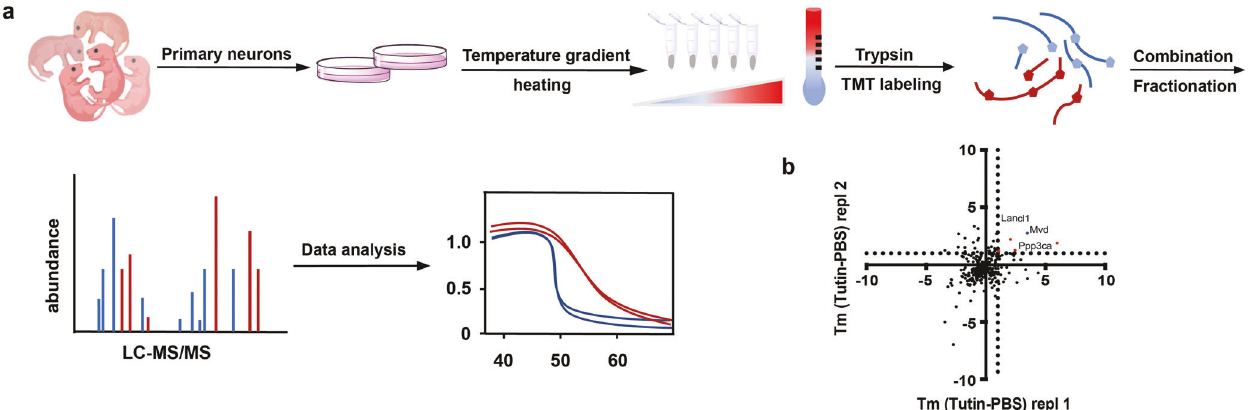
Fig. 2 Target identi fi cation of tutin in primary hippocampal neurons is conducted using TPP-TR. a Schematic procedure of TPP-TR. b Scatterplot of Tm shifts of tutin vs. PBS treatment. The TPP R package was used for calculating the thermal response curve fi tting and melting